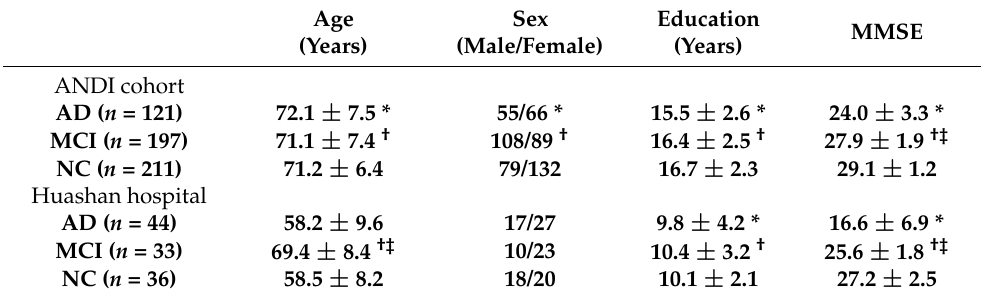
Table 1. Demographic, clinical characteristics for ANDI cohort and Huashan hospital